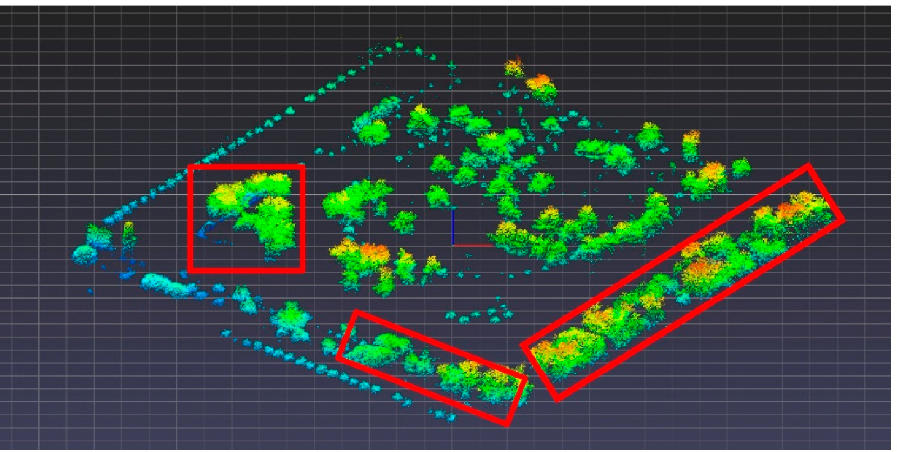
Figure 5. Classified high vegetation points in the study area (dense and mixed tree points in red rectangles).